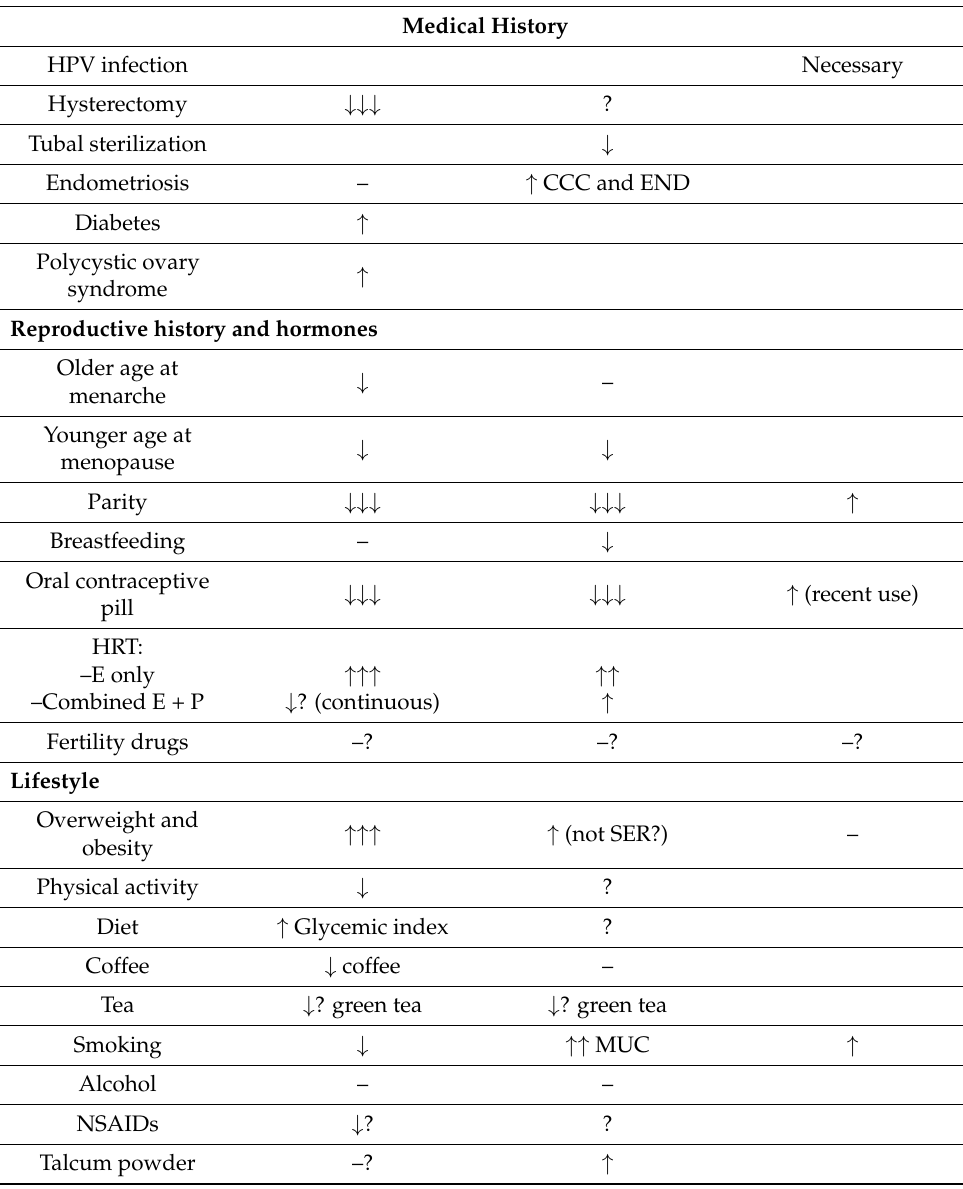
Table 1. The number of arrows indicates the strength of the association. ↑ : Increased risk; ↓ : Decreased risk; –: No evidence for an association; ?: Some evidence for association/lack of association but not confirmed; CCC: Clear cell cancer; E: Estrogen; END: Endometrioid cancer; HRT: Hormone replacement therapy; MUC: Mucinous cancer; P: Progesterone; SER: Serous cancer. Table adapted from Webb